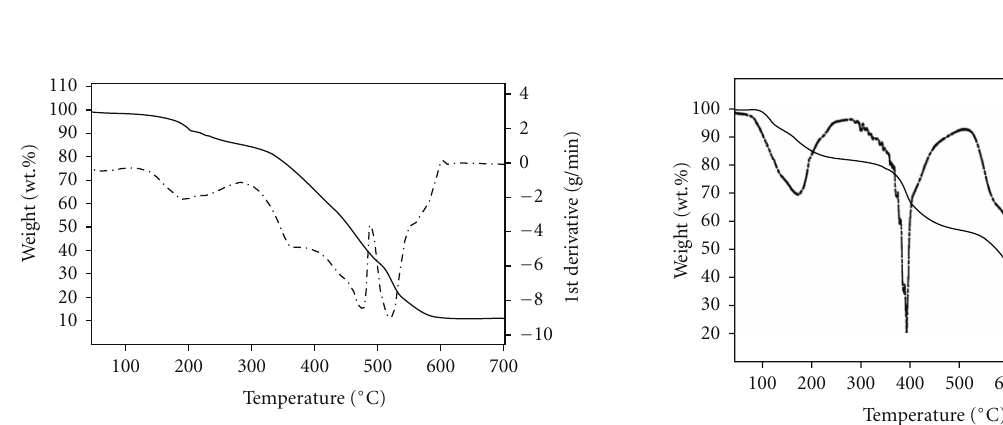
Figure 8: Thermographs of the Ir(III) complex of L I H (C 6 ).